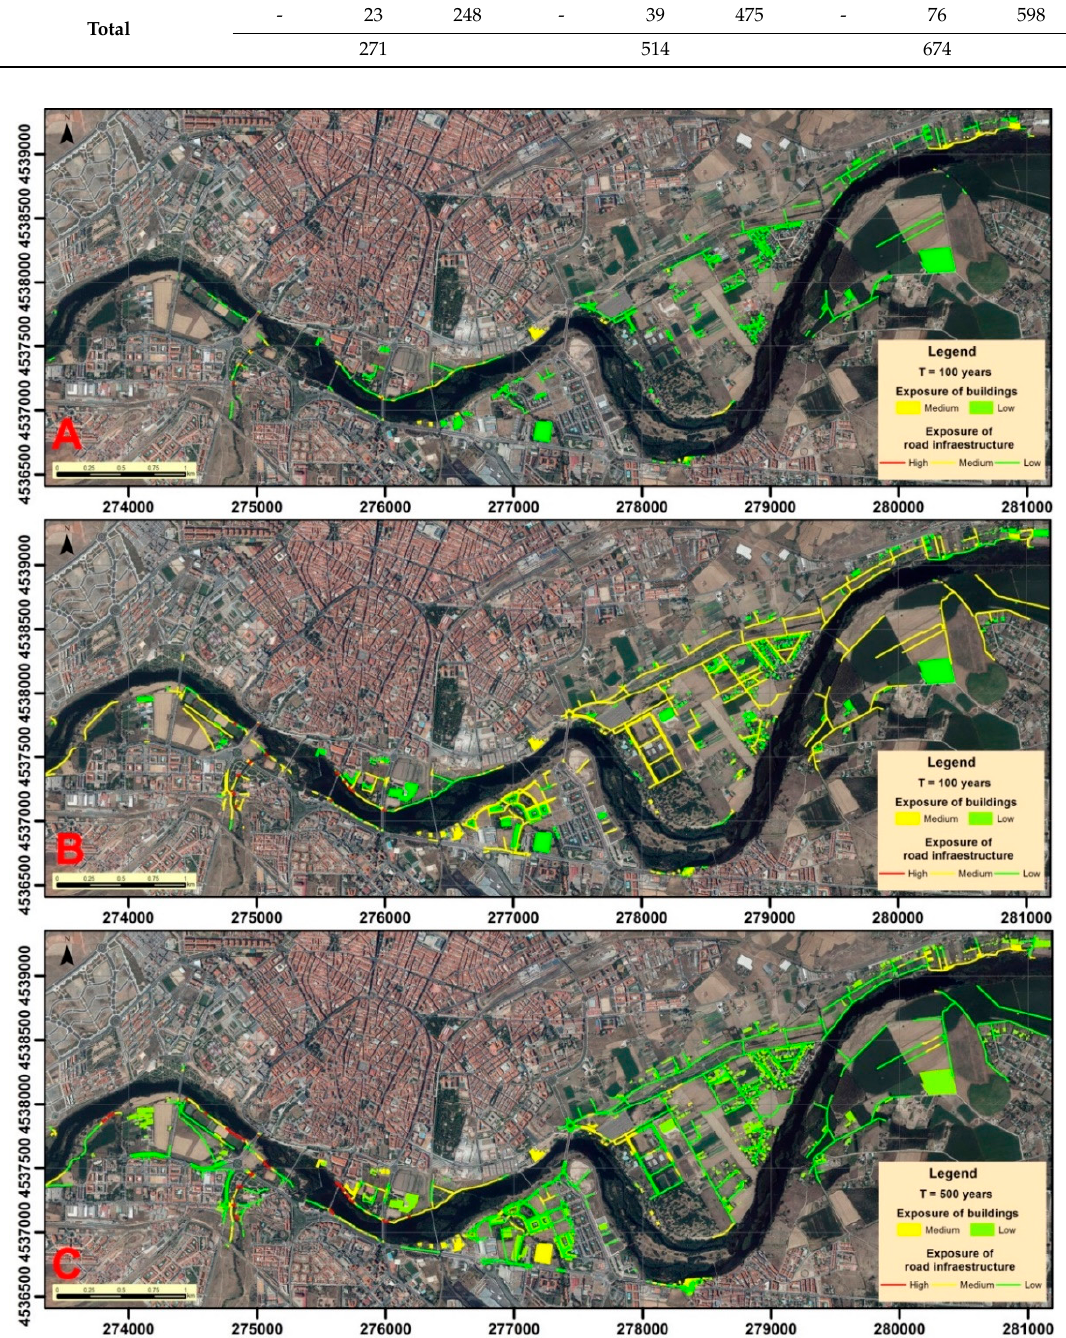
Figure 8. Exposure of the elements identified in the different return periods: ( A ) T = 5 years; ( B ) T = 100 years; and ( C ) T = 500 years. Table 6. Impact of floods (km) on different types of urban roads in each scenario.